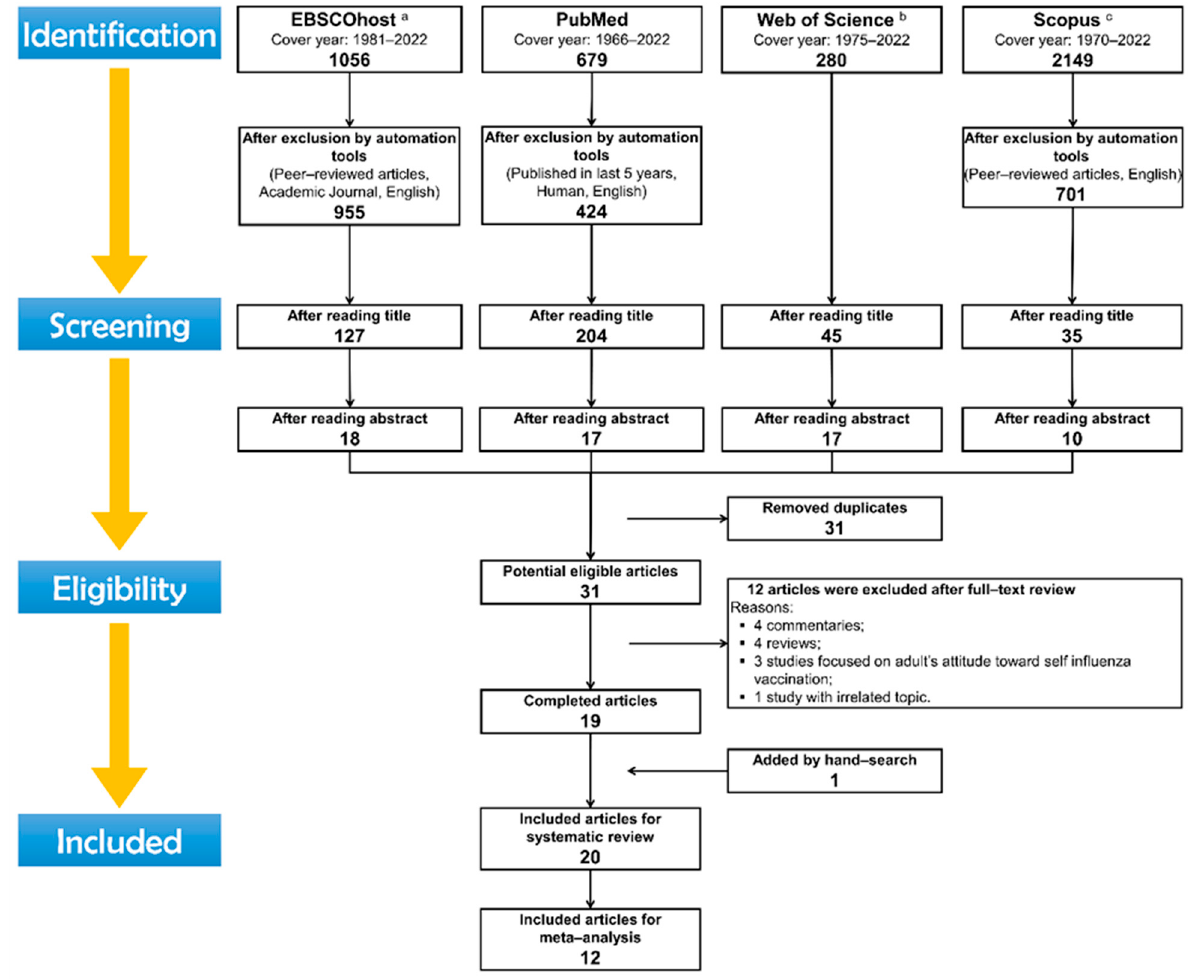
Figure 1. Preferred reporting items for systematic reviews and meta-analyses (PRISMA) flow diagram: search process for study selection about parental willingness to pediatric vaccination in the era of COVID-19. a Included databases of EBSCOhost are CINAHL with Full Text, ERIC, MEDLINE, APA PsycArticles, APA PsycInfo; b included databases of Web of Science are SSCI and A&HCI; c included both published papers and preprinted services.